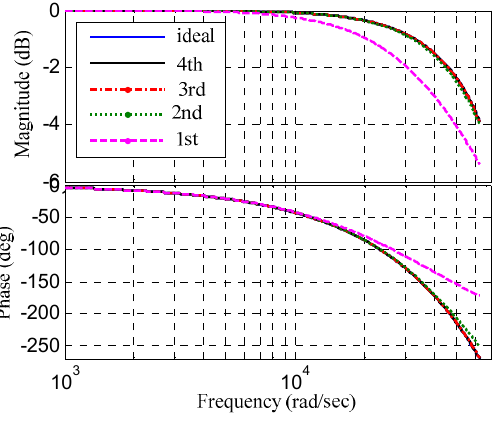
Figure 4. Frequency responses of G d with Padé approximations of various orders.